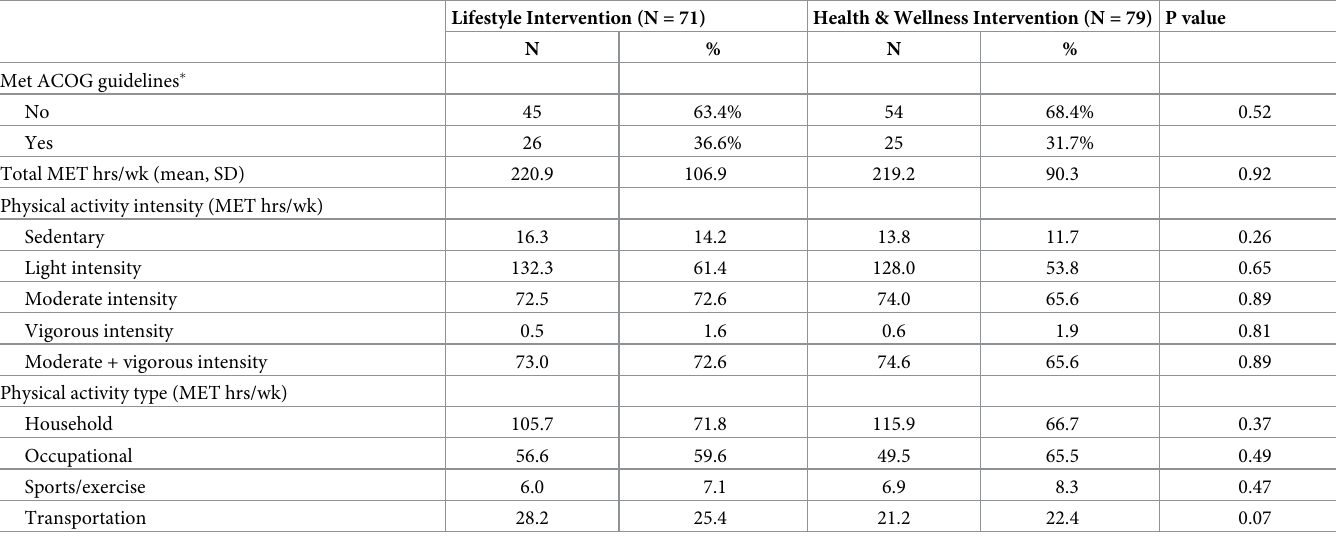
Table 2. Baseline physical activity according to intervention group (n = 150); Estudio PARTO 2013–2017. Lifestyle Intervention (N =